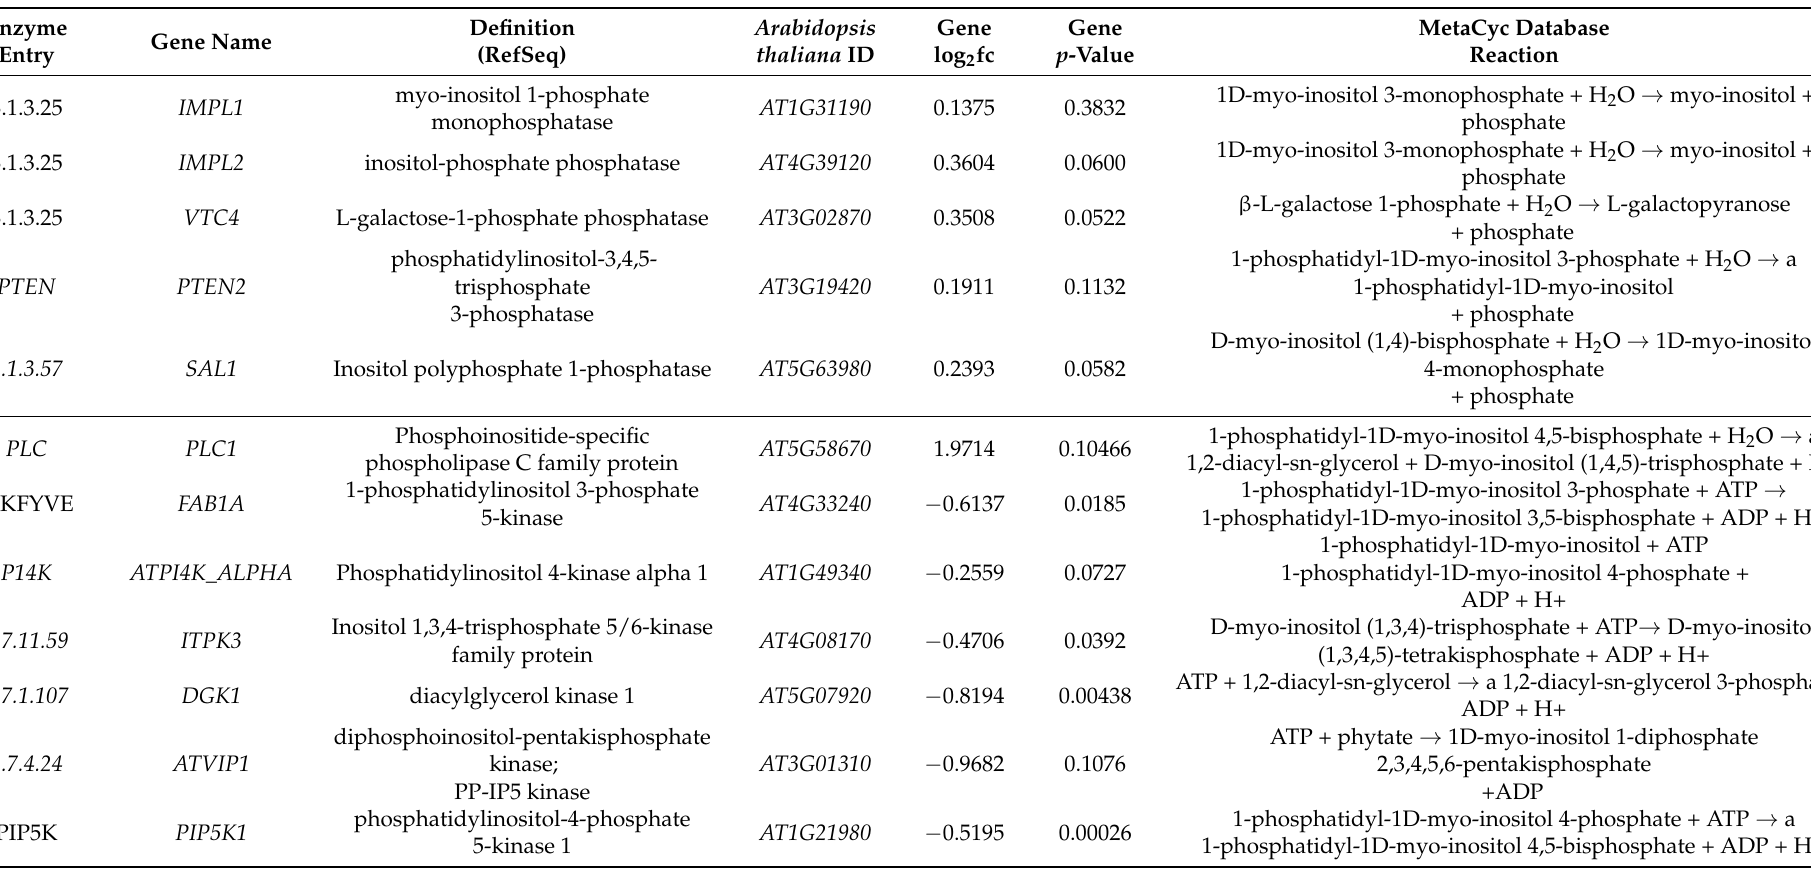
Table 5. Description of differentially expressed guar transcripts involved in the phosphatidylinositol signaling pathway based on homology with Arabidopsis thaliana on KEGG map obtained by Clusterprofiler (pathway ath04070